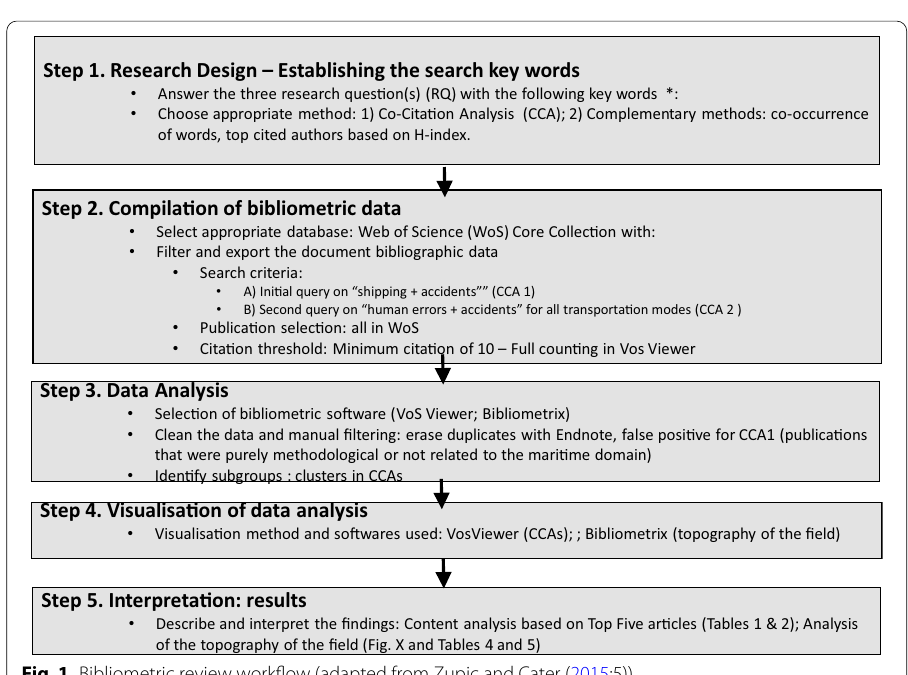
Fig. 1 Bibliometric review workflow (adapted from Zupic and Cater